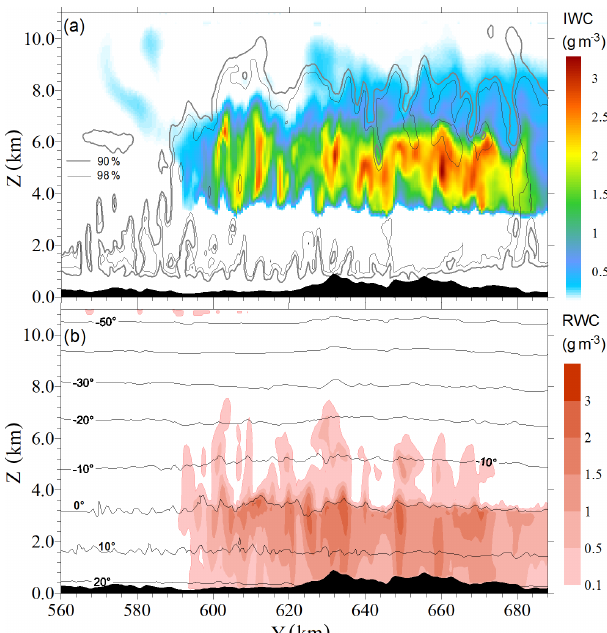
Figure 6. Vertical cross section of (a) modelled ice water content (IWC) and (b) modelled rainwater content (RWC) along the main precipitation field for the innermost model domain at 08:20UTC. The isocontours in (a) also indicate the regions with relative hu- midity larger than 90% and 98%; isotherms in degrees Celsius are depicted in (b) . The cross section is oriented in the NNW direction and its projection on the y axis presents the